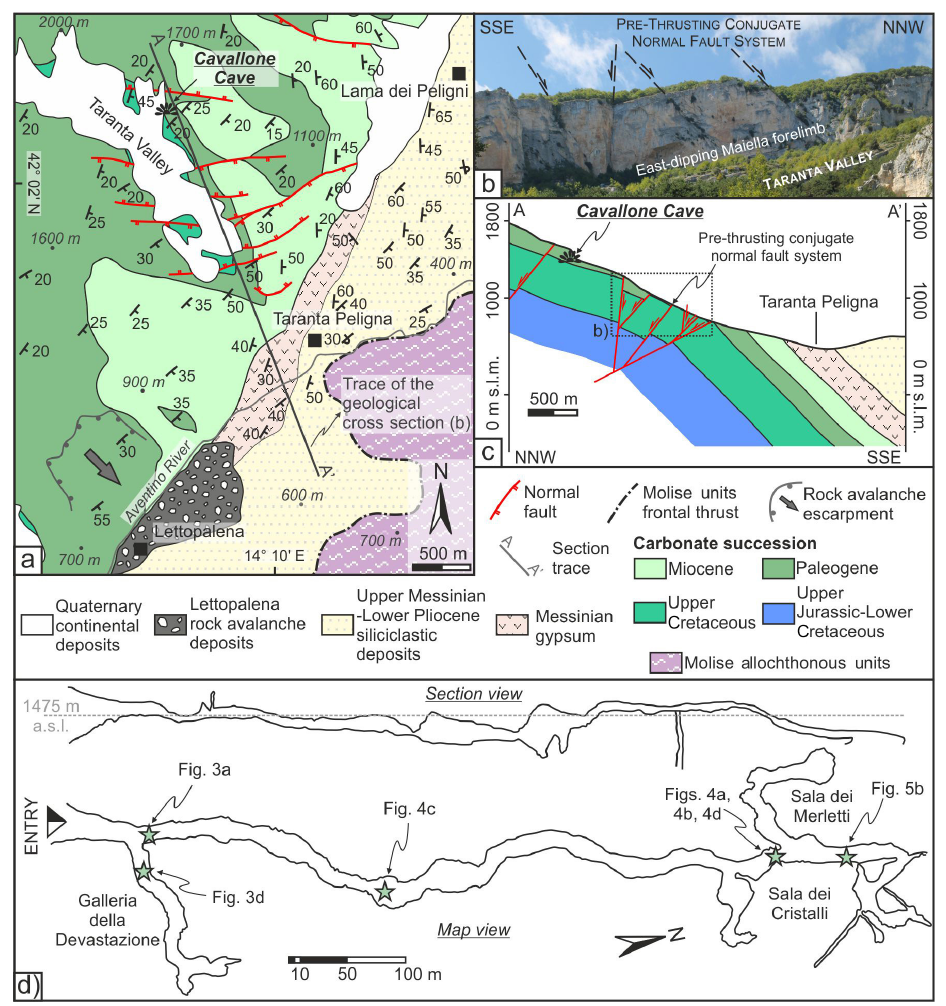
Figure 2. Schematic geological map of the study area (a) (simplified from Accotto et al., 2014; see Fig. 1 for the location) and geological cross section along the Taranta Valley (c) showing SE-dipping Meso-Cenozoic carbonates, passing to Mio-Pliocene gypsum and siliciclastic deposits, describing the forelimb of the Maiella anticline. E–W-trending normal faults represent pre-thrusting conjugate normal fault systems (b) . The Cavallone Cave is located along the cliffs of the Taranta Valley, in the southeastern portion of the Maiella Massif; to the south, the village of Lettopalena is situated on top of rock avalanche deposits. (d) Section and map views of the Cavallone Cave showing the articulate morphology of the cave